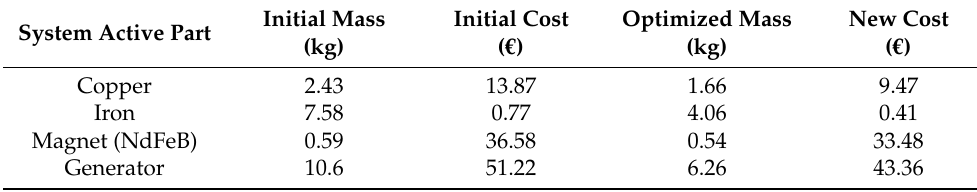
Table 5. The mass and cost of reference and optimized PMSG.